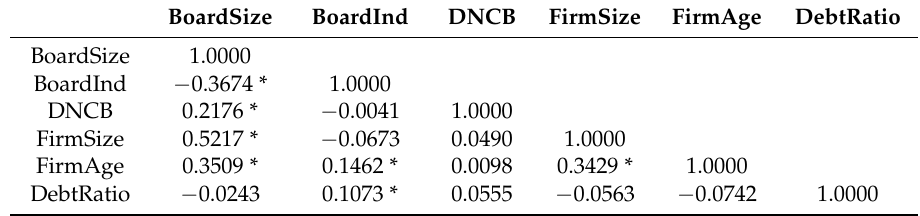
Table 3. Correlation matrix. This table presents the pairwise correlations between independents variables. BoardSize BoardInd DNCB FirmSize FirmAge